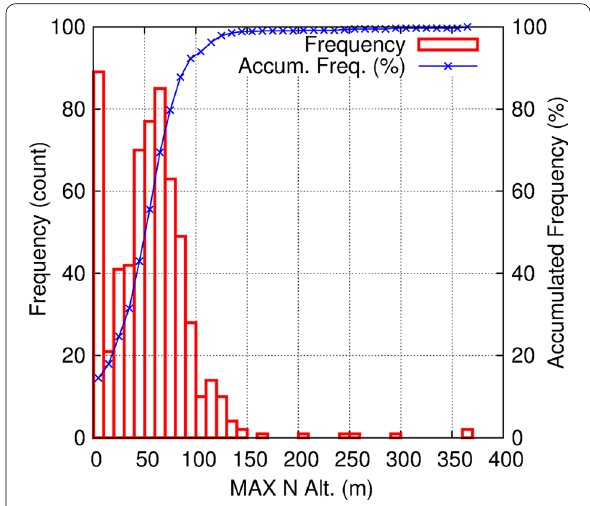
Fig. 11 Frequency of the height of the maximum refractivity of 612 RYOFU MARU radiosonde observations during the period of